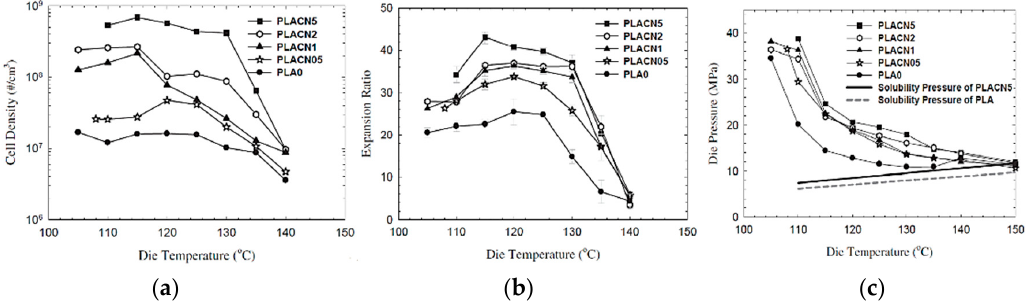
Figure 30. ( a ) Cell density and ( b ) expansion ratio of PLA & PLA/Cloisite 30 (PLACN) foams processed at various die temperatures, and ( c ) die pressure and solubility pressure at various die temperatures. Reprinted from Keshtkar et al. [151]. Copyright (2020), with permission from Elsevier.